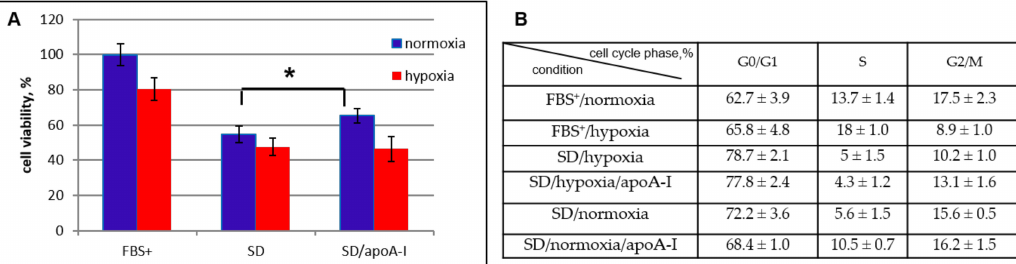
Figure 2. The e ff ect of apoA-I on ( A ) the viability of bone marrow mesenchymal stem / stromal cells (MSCs) under conditions: with fetal bovine serum (FBS + ) / hypoxia (5% O 2 ); FBS + / normoxia (20% O 2 ); serum deprivation (SD) / hypoxia; SD / normoxia and SD / hypoxia / apoA-I, SD / normoxia / apoA-I and ( B ) cell cycle of bone marrow MSCs under the same conditions assayed by flow cytometry analysis. * p <